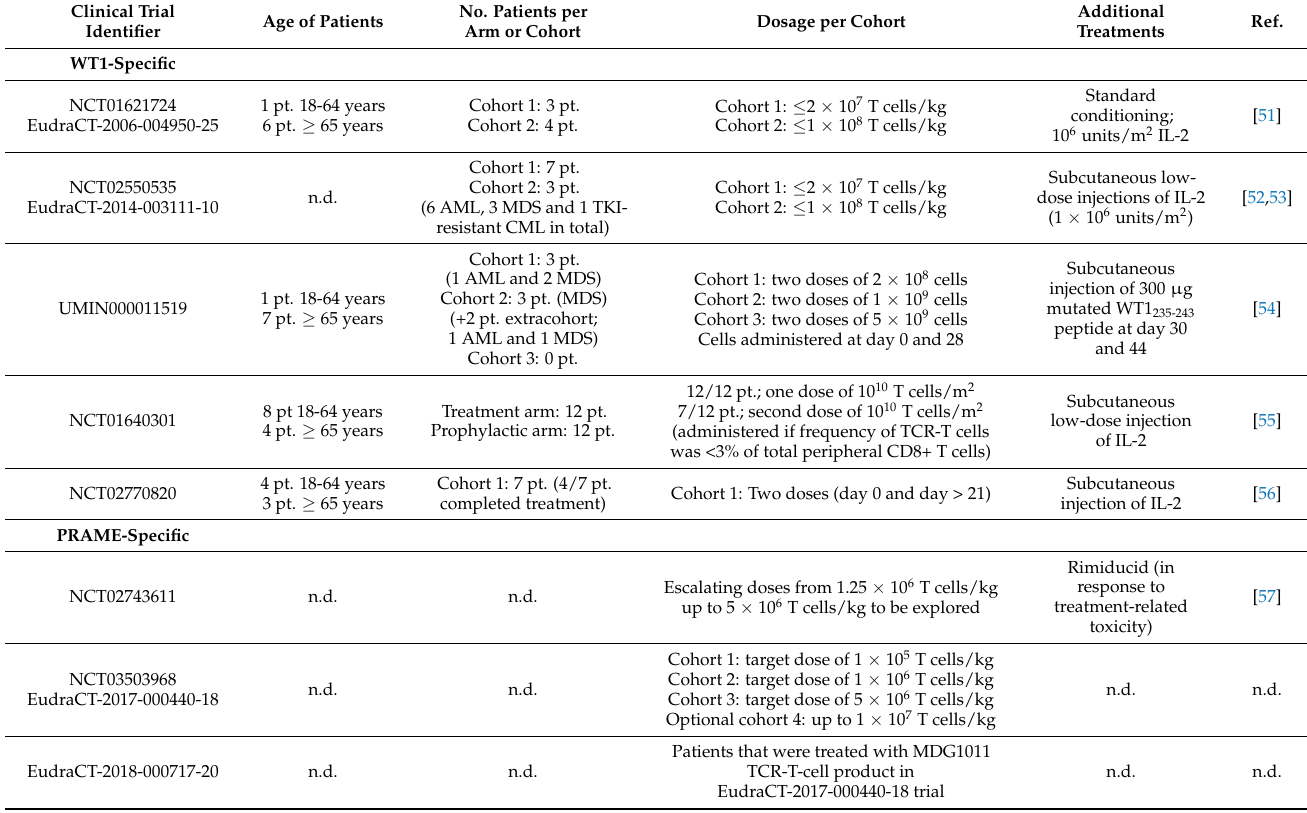
Table 3. Patient characteristics and treatment